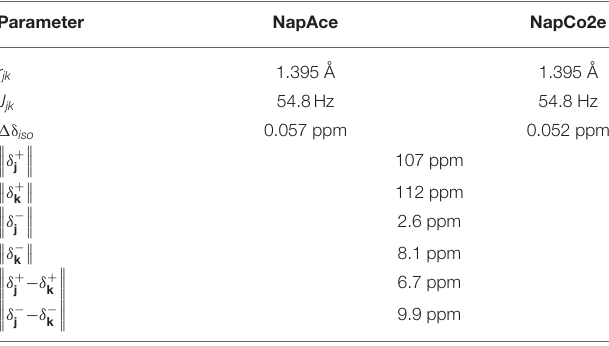
TABLE 6 | Parameters used in the relaxation analysis for the case of NapAce and NapCo2e . Parameter NapAce